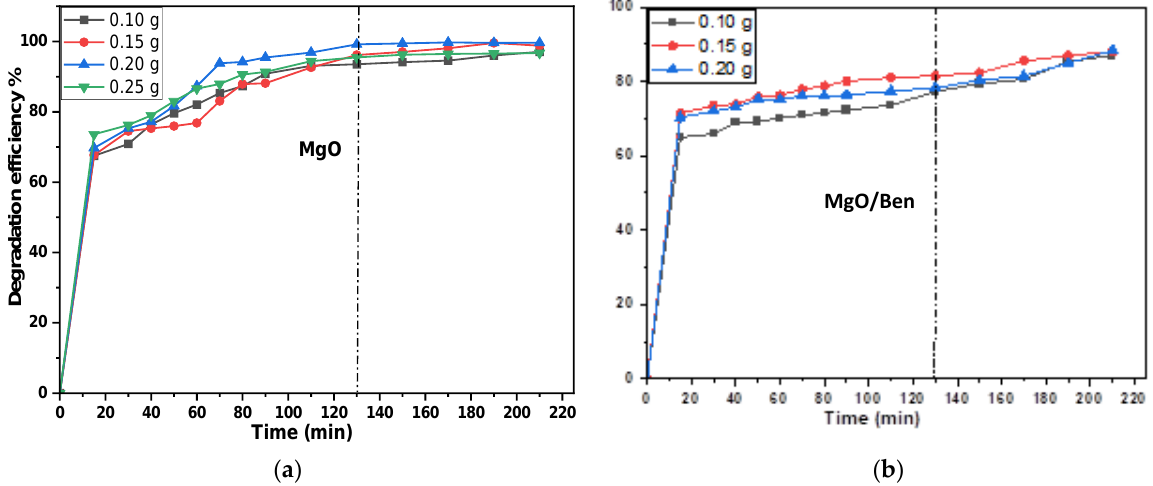
Figure 6. The catalyst dose effect on the photocatalytic degradation of CV for ( a ) MgO NPs and ( b ) MgO/Ben nanocomposite. Table 1. Rate constants of apparent pseudo-first order, K ap (min −1 ), of degradation of CV by different catalyst doses of MgO NPs and MgO/Ben nanocomposite.